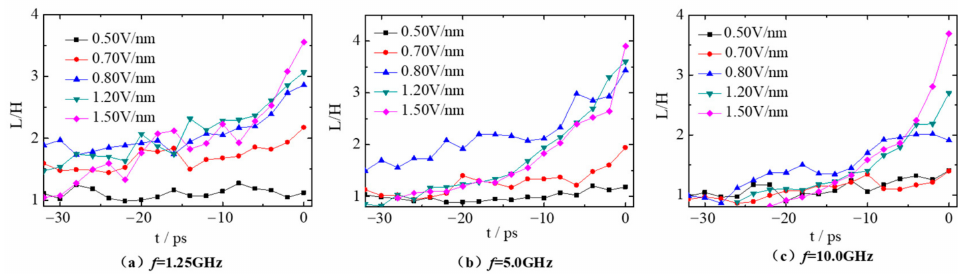
Figure 4. Time evolution of the deformation parameter L/H of droplet 2 under different electric fields with frequency ( a ) f = 1.25 GHz, ( b ) f = 5.0 GHz and ( c ) f = 10.0 GHz. The deformation of droplets is not only affected by the electric field strength but